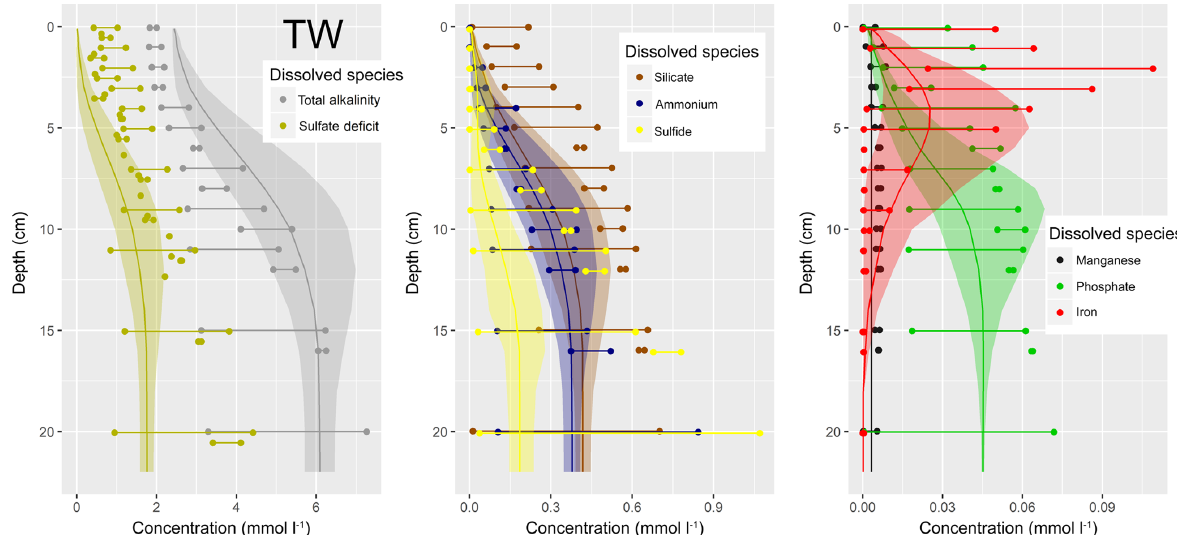
Figure 6. Pore water concentrations of several dissolved species at the silt station Tromper Wiek. Points and horizontal lines indicate the range of measurements. Curves and shading present the model results and indicate year-average concentrations and the seasonal